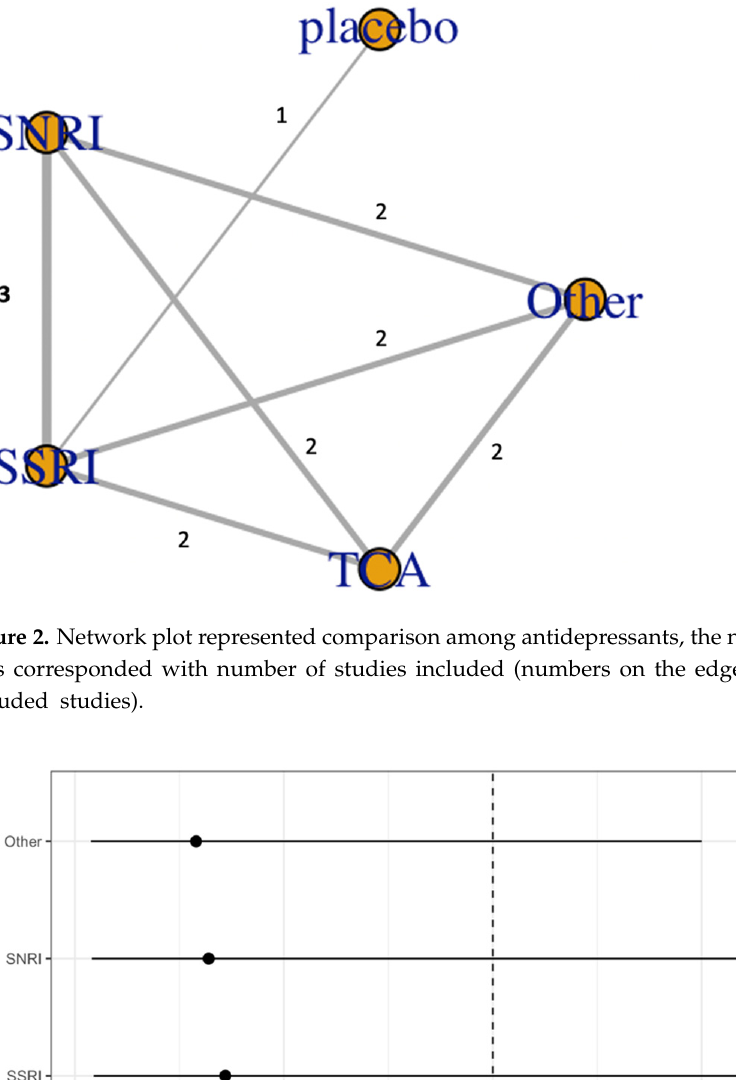
Figure 3. Forest plot demonstrated the relative effect of antidepressants compared to placebo.